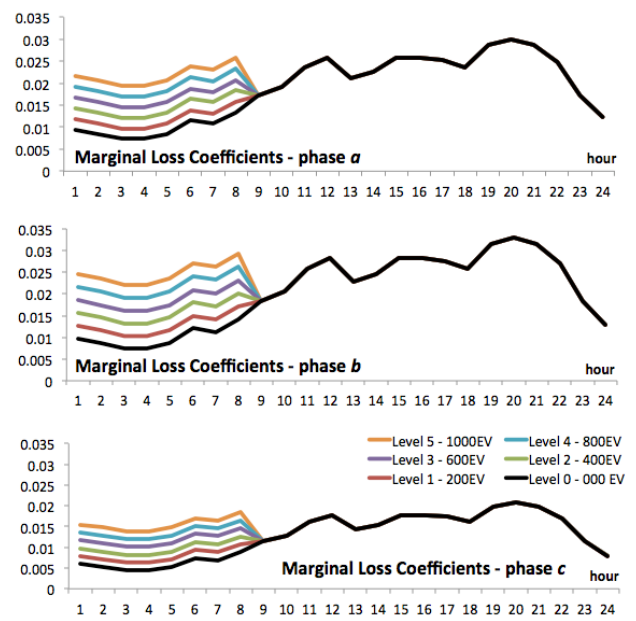
Figure 5. Off-peak load scenario: marginal loss coefficients (MLCs) at Bus 21 by EV penetration level and by time.